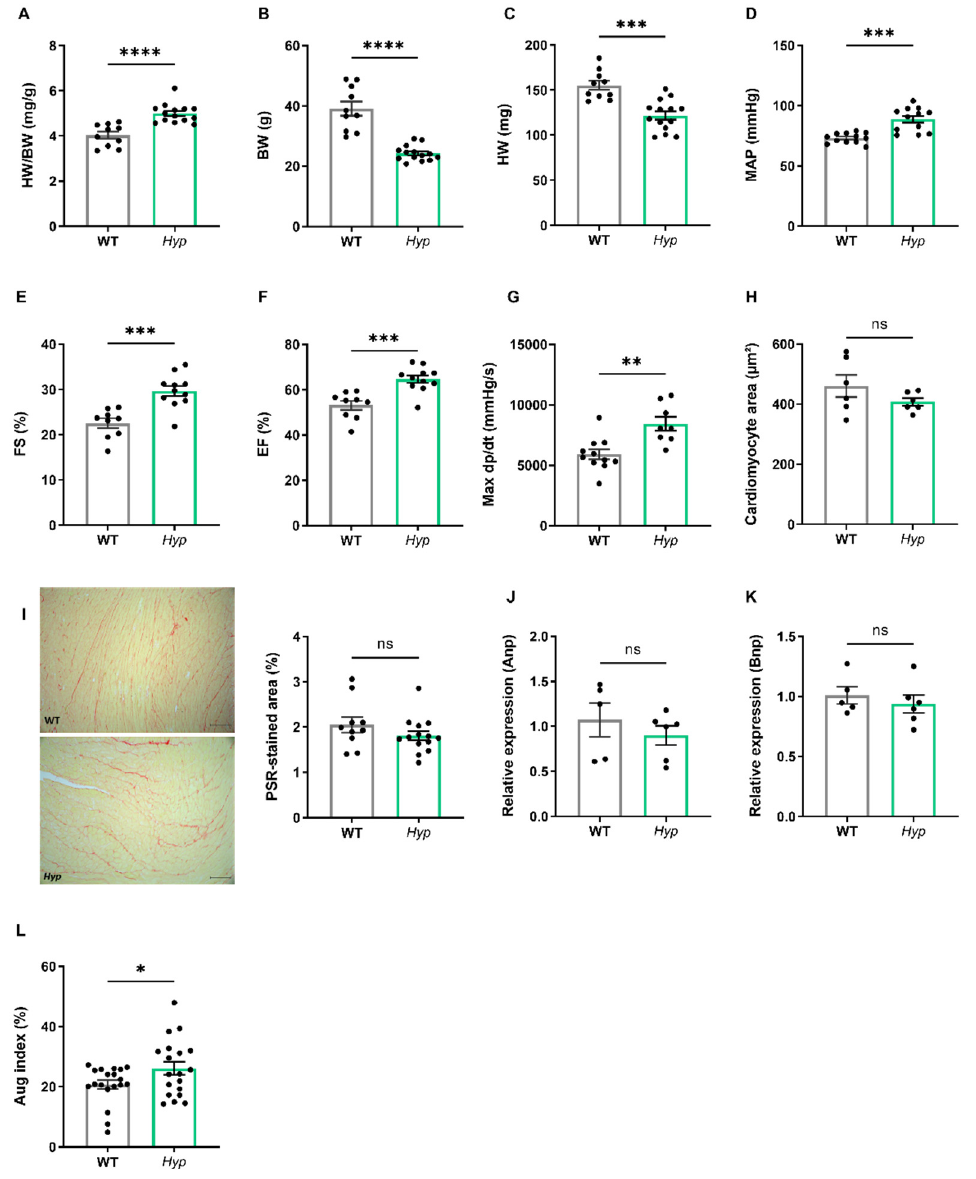
Figure 2. Hyp mice are hypertensive but do not develop LV hypertrophy. ( A ) Heart/body weight ratio (HW/BW), ( B ) body weight (BW), and ( C ) heart weight (HW) (n = 4–14) in 14-month-old male WT and Hyp mice. ( D ) Mean arterial pressure measured by arterial catheterization (n = 12), ( E , F ) fractional shortening (FS) and ejection fraction (EF) measured by echocardiography (n = 9–11), and ( G ) LV contractility (Max dP/dt) measured by intracardiac catheterization (n = 12) in 14-month-old male WT and Hyp mice. ( H ) Quantification of mean cardiomyocyte size after FITC-WGA staining (n = 6), ( I ) left, representative images of collagen staining using picrosirius red (PSR) in cardiac paraffin sections (bar = 100 µ m), right, quantification of fibrosis as measured by PSR-stained area (n = 9–12), ( J , K ) relative mRNA expression of markers of hypertrophy, ( J ) atrial natriuretic peptide (Anp) and ( K ) brain natriuretic peptide (Bnp) (n = 5), and ( L ) augmentation index (AI) measured by pulse wave analysis (n = 19) in 14-month-old male WT and Hyp mice. Bars in ( A – L ) represent mean ± SEM. * p < 0.05, ** p < 0.01, *** p < 0.001, **** p < 0.0001 by Student’s t -test. ns, not significant.